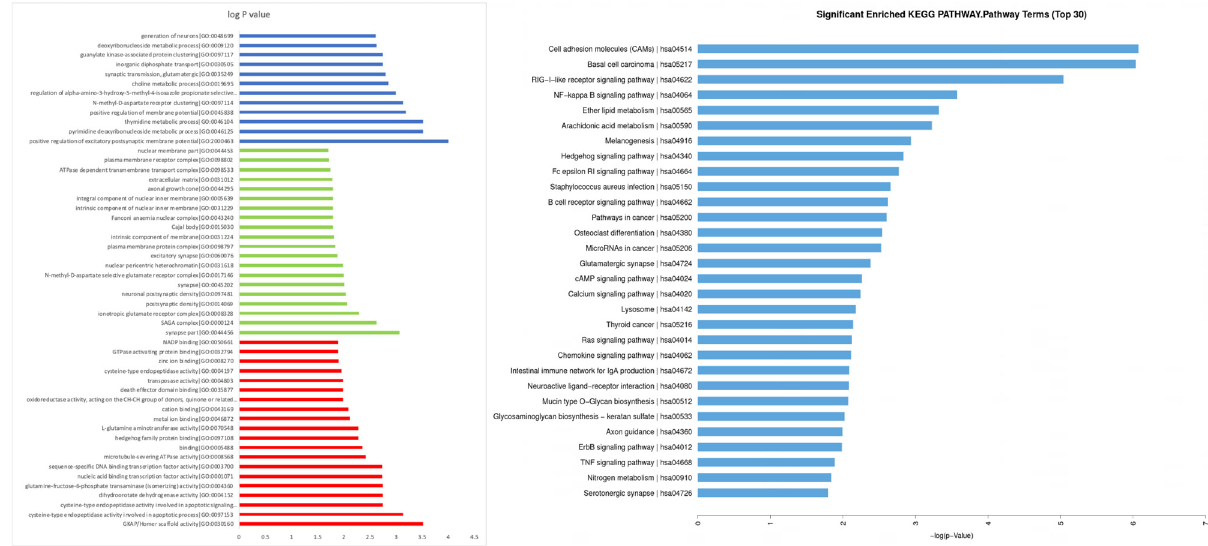
Figure 4: GO analysis of the predicted lncRNA target genes. Data are presented as a histogram of the relevant biological processes, cellular components, and molecular functions identi fi ed. KEGG pathway analysis of predicted lncRNAs is presented as a potential